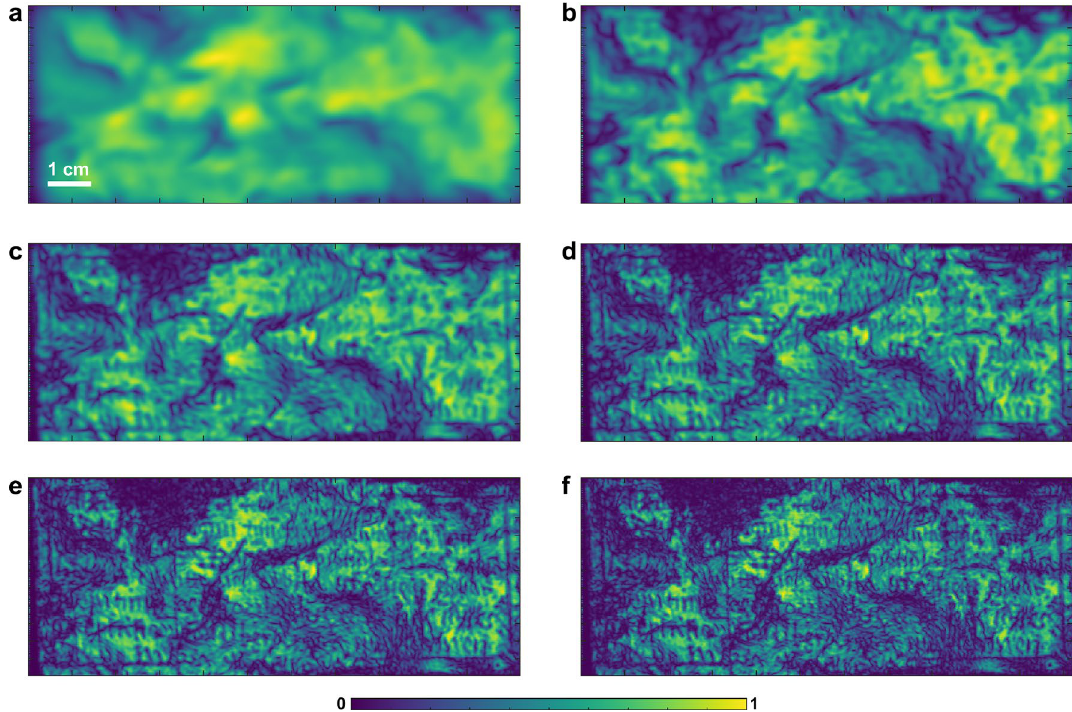
Figure 3. THz multispectral images obtained based on the components in frequency bands within ( a ) 0.1 and 0.5 THz, ( b ) 0.5 THz and 1.0 THz, ( c ) 1.0 THz and 1.5 THz, ( d ) 1.5 THz and 2.0 THz, ( e ) 2.0 THz and 2.5 THz, ( f ) 2.5 THz and 3.0 THz. Features associated with the inscriptions start to appear in the frequency bands above 1 THz, and images from the low frequency bands mainly reflect the surface morphology of the cross. All the images are normalized to their maximum pixel